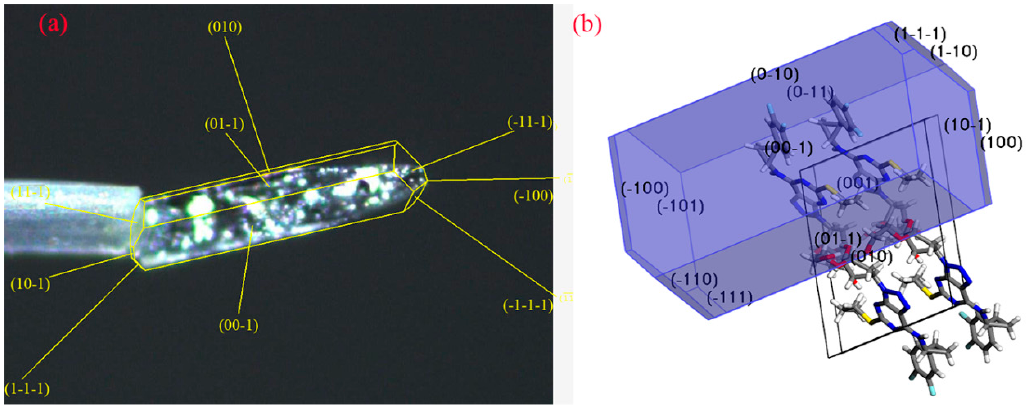
Figure 6. ( a ) Face indexation for TICA form Ⅱ and ( b ) Morphology predictions for TICA form Ⅱ by means of BFDH calculations.